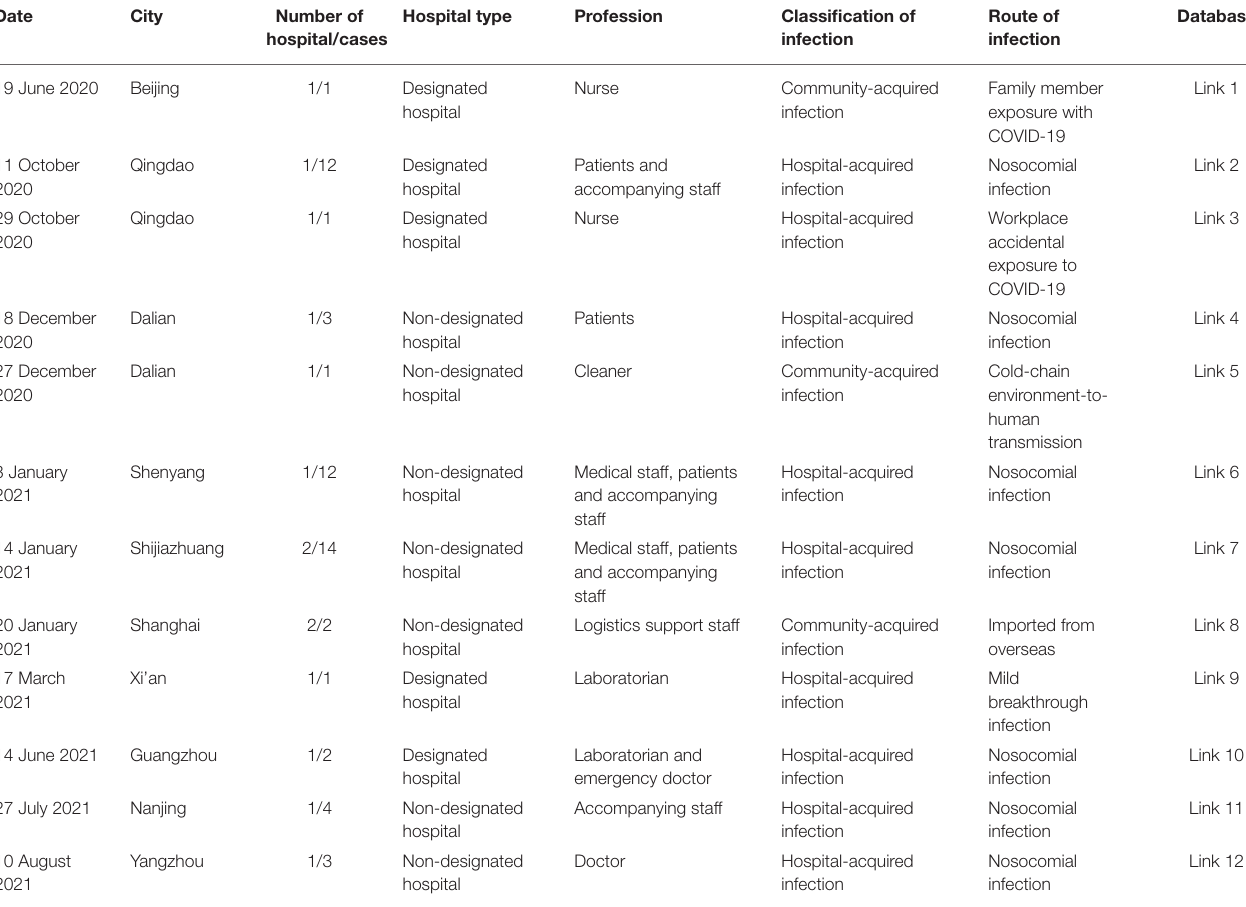
TABLE 1 | Epidemiological characteristics of sporadic nosocomial COVID-19